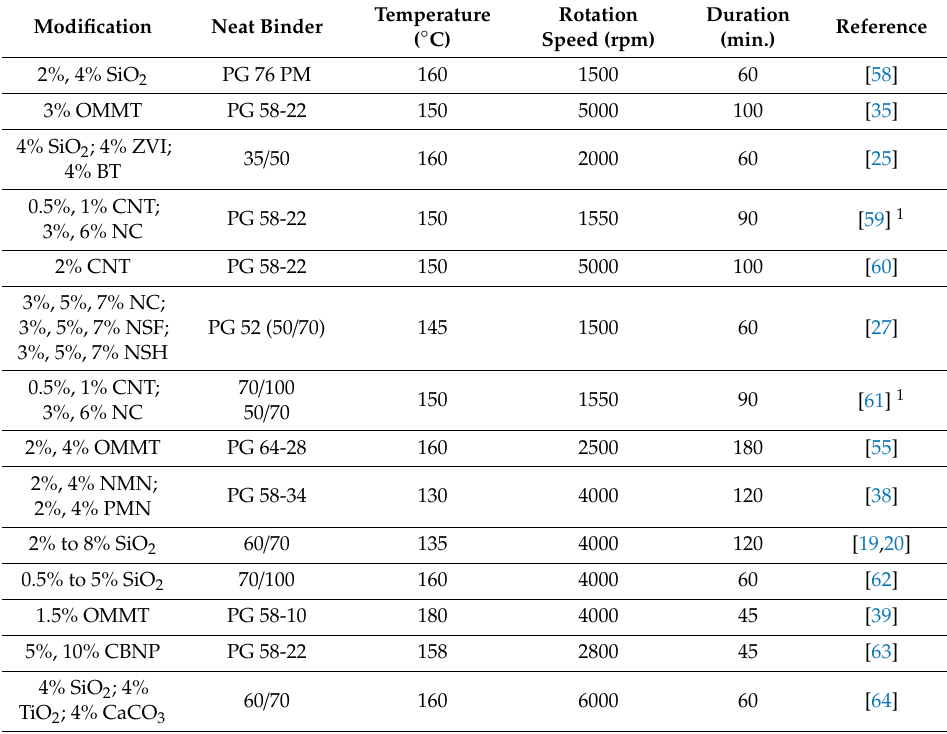
Table 4. Dry blending configurations used by several